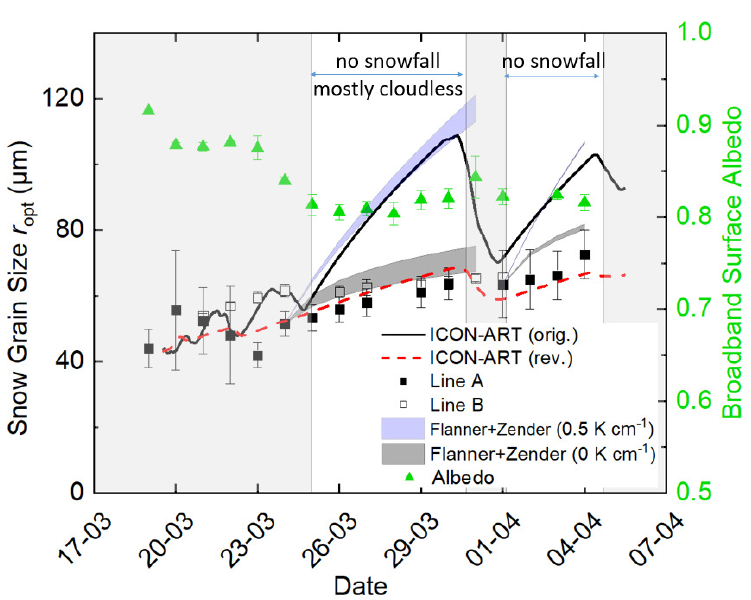
Figure 5. Locally averaged IceCube measurements of the snow grain size during PAMARCMiP at two locations (along line A and line B) in the vicinity of the Villum research station. Bars give the standard deviation of the spatial averaging. Mean broadband surface albedo derived from ground- based pyranometer data near line A is additionally shown (triangles). ICON-ART modeled snow grain sizes are indicated as black solid and red dashed lines. Spread of parametrization result of the snow grain size evolution after Flanner and Zender [44] is shown as dark gray and light blue